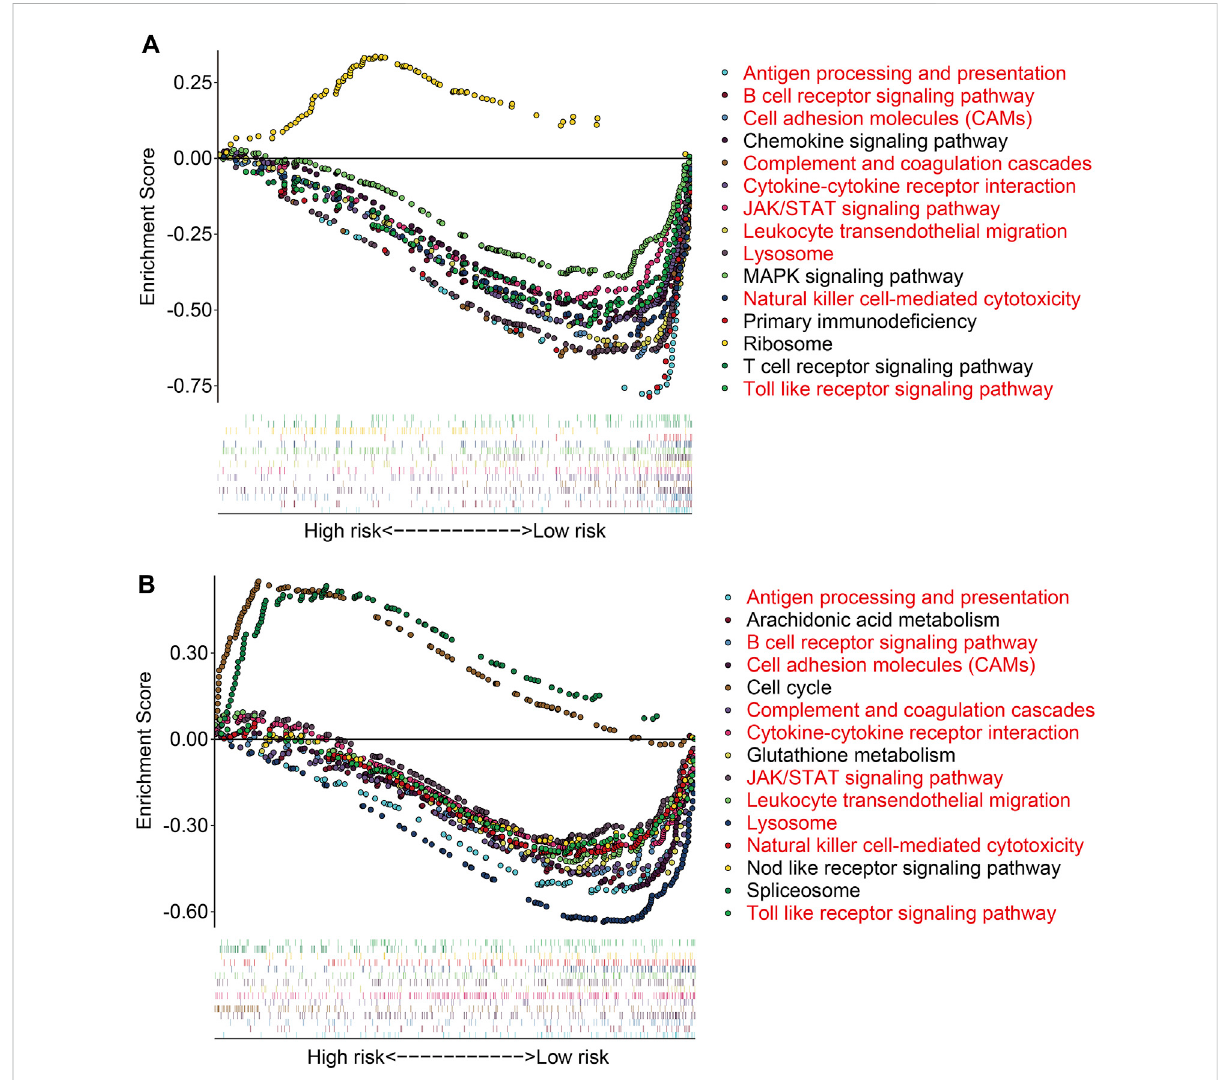
FIGURE 8 Gene set enrichment analysis between high- and low-risk groups in the TCGA cohort (A) and the GSE16091 cohort (B)